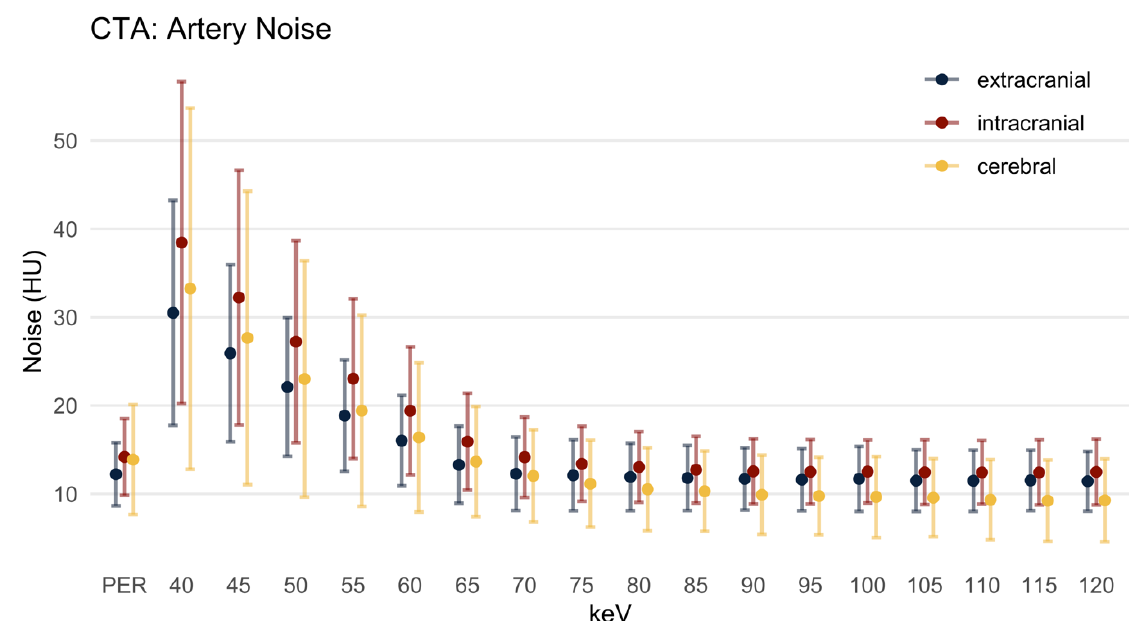
Figure 3. Artery noise in Hounsfield units, mean ± SD. HU: Hounsfield units; PER: polyenergetic reconstruction; keV: keV level of the monoenergetic reconstruction. Extracranial: internal carotid artery C1 segment and vertebral artery V3 segment; intracranial: internal carotid artery C4 segment and basilar artery; cerebral: ACA, MCA and PCA.